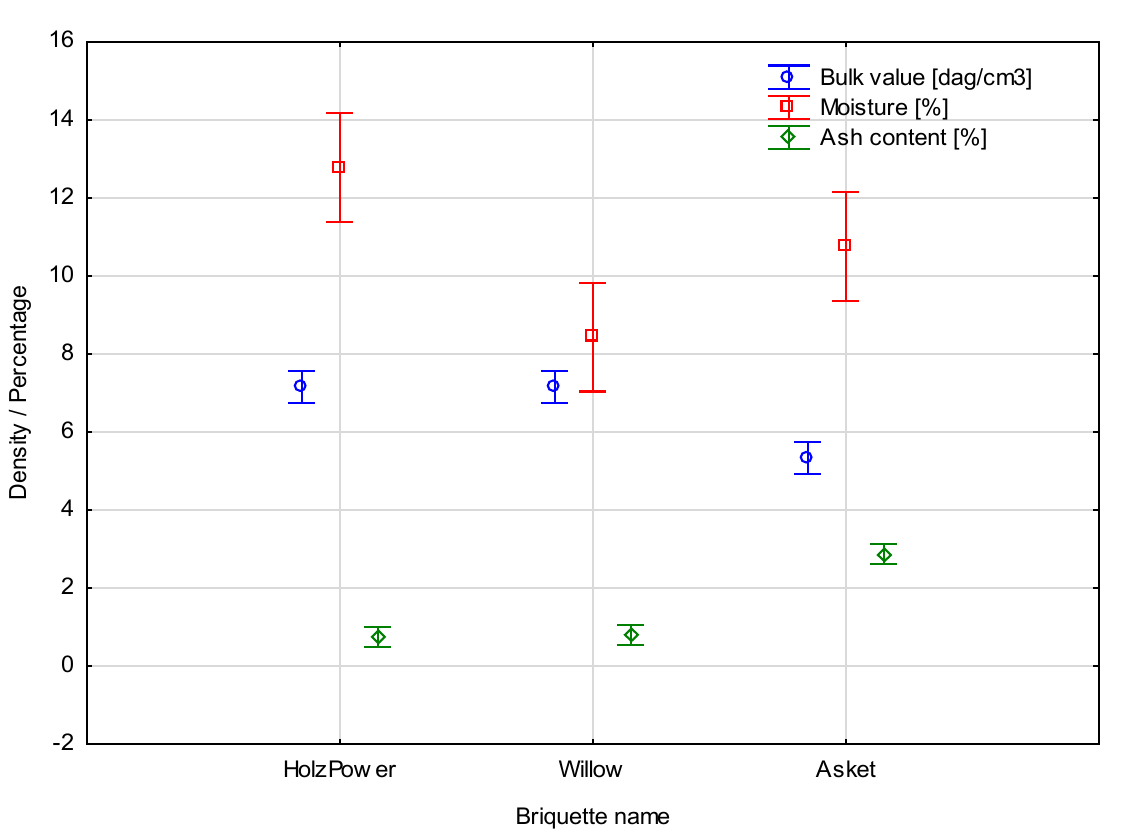
Figure 1. Sums for the briquettes made from various biofuel materials. Table 3. Characteristics of the effect of the material type on bulk density for the briquette